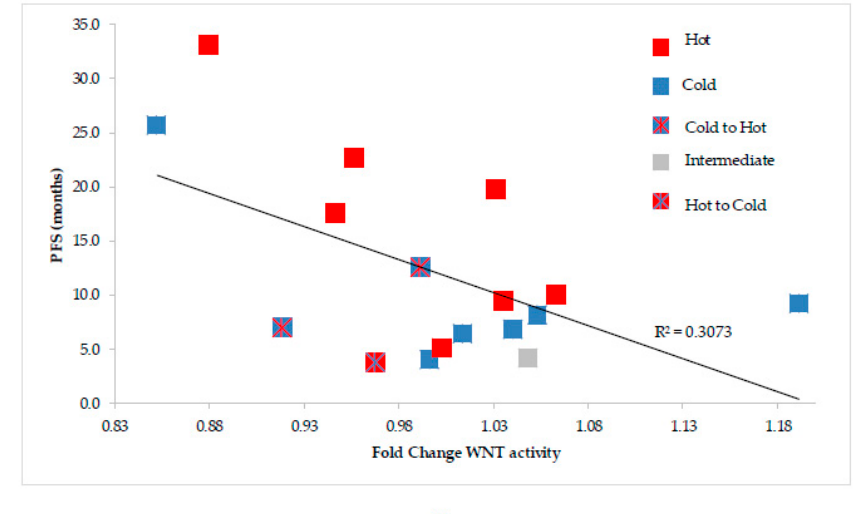
Figure 2. Wnt and immune gene signature in ovarian cancer patient samples. ( a ) T cell signatures and Relative Wnt Activity scores calculated from RNA-seq data for 57 treatment naïve human HGSC tissues show a negative correlation. ( b ) Kaplan–Meier curve for PFS ( n = 17) based on decreases in Wnt activity after NACT. ( c ) Kaplan–Meier curve for OS ( n = 17) in correlation with decreased Wnt activity after NACT. ( d ) PFS shows a negative association with fold change in Wnt activity measured by signature genes in matched post- versus pre-NACT in 17 HGSC patients. Samples are labeled based on T cell signature changes, with a solid color indicating no change, a blue square with red lines indicating cold-to-hot signature change and a red square with blue lines indicating a hot-to-cold signature